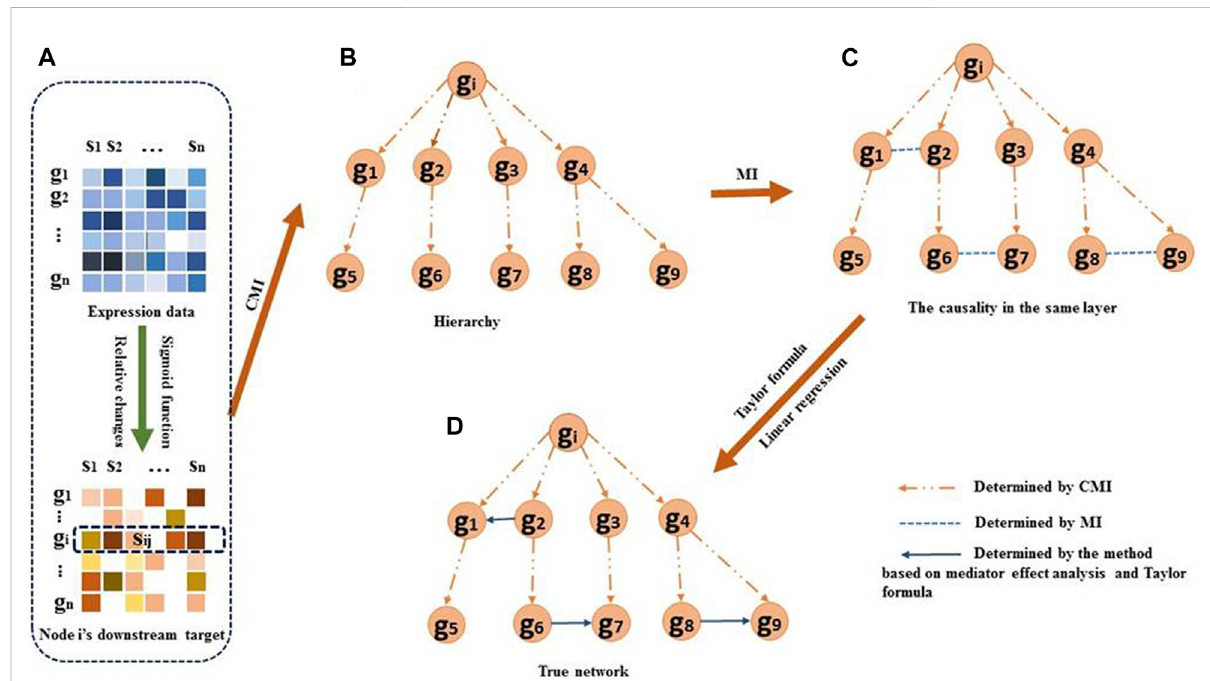
FIGURE 1 OverviewoftheDDTGmethod. (A) Foreachregulator g i ,thedownstreamtargetgenes s ij oftheregulatorareidenti fi edbytheSigmoidfunction and by comparing the relative change values. (B) Hierarchy structure of downstream target genes will be decided by using CMI. Assuming genes g 1 – g 9 arethedownstreamtargetgenesofregulator g i .Asanexample,genes g 1 and g 5 belongtothe2combinationofthedownstreamtargetgenes. If I ( g i , g 5 | g 1 ) is small, it indicates that g i regulates g 1 directly and g 1 regulates g 5 directly. The dashed arrows denote the regulatory direction. (C) The correlations between two genes in the same layer. The dashed lines without arrows denote the genes being strongly dependent on each other. Edges g 1 – g 2 , g 6 – g 7 ,and g 8 – g 9 aredirectlycorrelatedwitheachotherinthesamelayer. (D) Theregulatorydirectionbetweentwogenesinthesame layer is determined using the Taylor formula and linear regression. The solid arrows denote the causality in the same layer. The reconstruction of GRNs is achieved by aggregating the edges from each